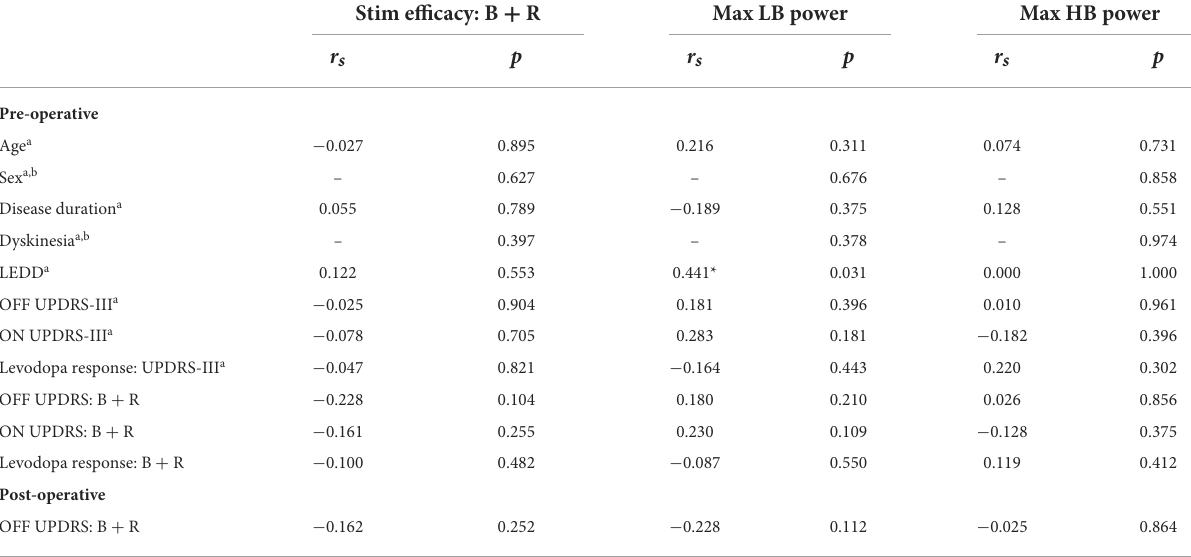
TABLE 3 Association of clinical characteristics with DBS efficacy and β frequency power. Stim efficacy: B +